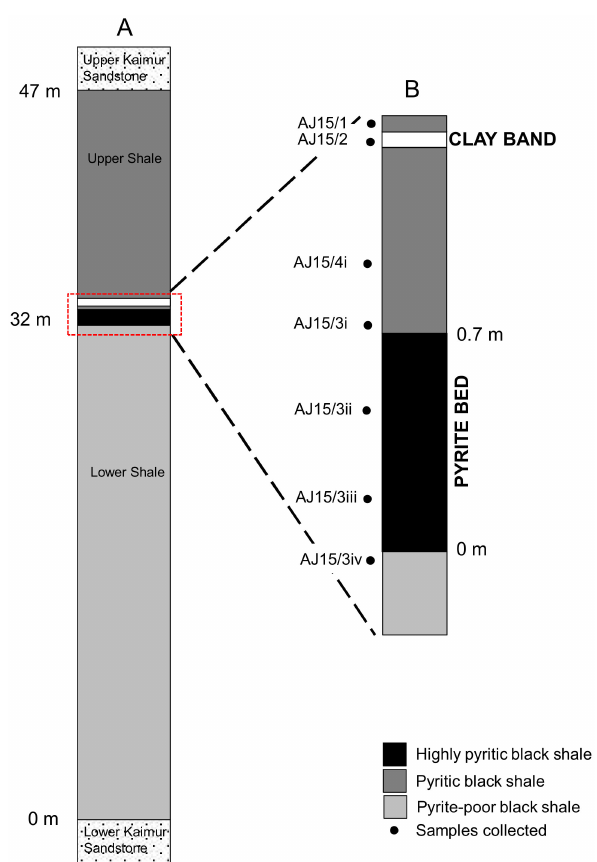
Figure3. ( A )StratigraphiccolumnoftheBijaigarhShaleunitatAmjhoremodifiedafter[39]; ( B )Location of samples collected for this